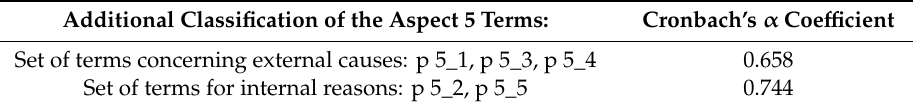
Table 5. Results of the Cronbach α coe ffi cient for factor analysis of aspect